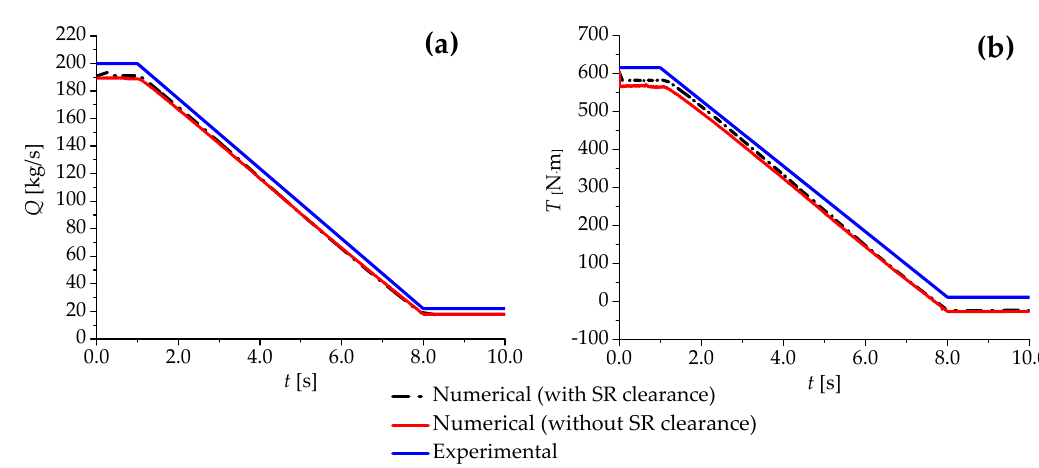
Figure 5 . Numerical simulation and experimental model test results for the Francis turbine with and without a seal ring (SR) clearance under a load rejection condition. ( a ) The mass flow rate Q across the spiral casing inlet. ( b ) The torque T of the runner.